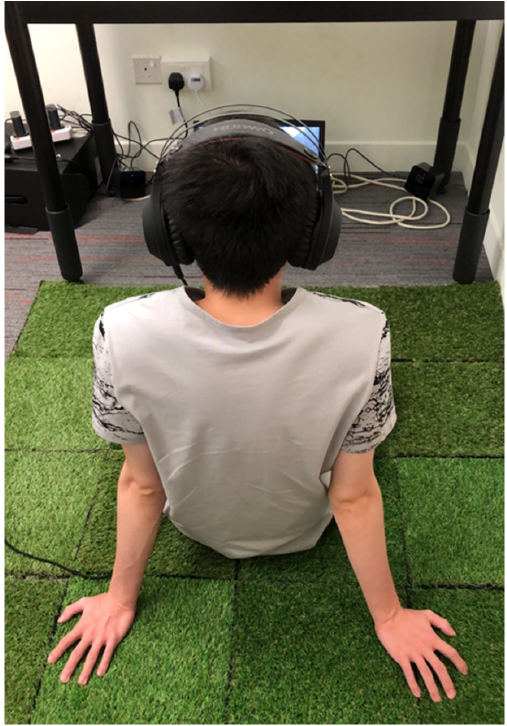
Figure 1. Participant using the HTC Vive VR system setup for the VR nature condition. Virtual exposures software. The Atmosphaeres 360° Virtual Reality Experiences appli- cation [79] was downloaded onto the Steam video game platform [80]. The Bavarian Alps video was selected for the VR-N and non-VR-N exposure. The non-VR-N exposure clip was a full-computer-screen display of a 6K high-resolution video of the same Bavarian Alps stock clip on YouTube [79]. The VR-U exposure was the street view of 225 Deansgate, Manchester, England on the Google Earth VR application [76]. Sample images of the ur- ban and nature environments are displayed in Figures 2 and 3, respectively.